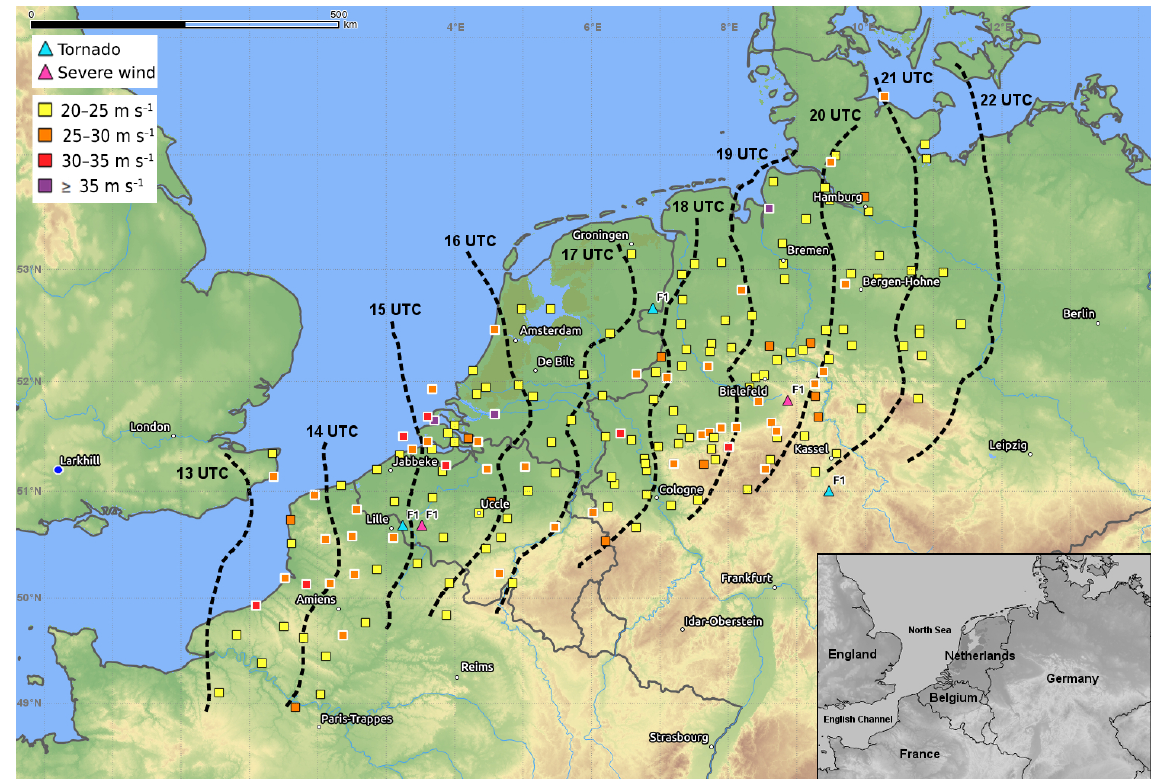
Figure 1. The radar-observed position of the leading edge of the derecho-producing mesoscale convective system at hourly intervals between 13:00 and 22:00UTC on 3 January 2014 is shown by the dashed black lines. The observed maximum wind gusts (ms − 1 ) are denoted by the small coloured squares (see legend). The white-edged squares indicate gusts stronger than 25.7ms − 1 . Tornadic and non-tornadic wind damage locations are marked by the small blue and magenta triangles, respectively (see legend). The dark blue dot denotes the location of the sounding shown in Fig. 6. The inset in the bottom-right-hand corner shows the names of the countries and sea areas within the investigation